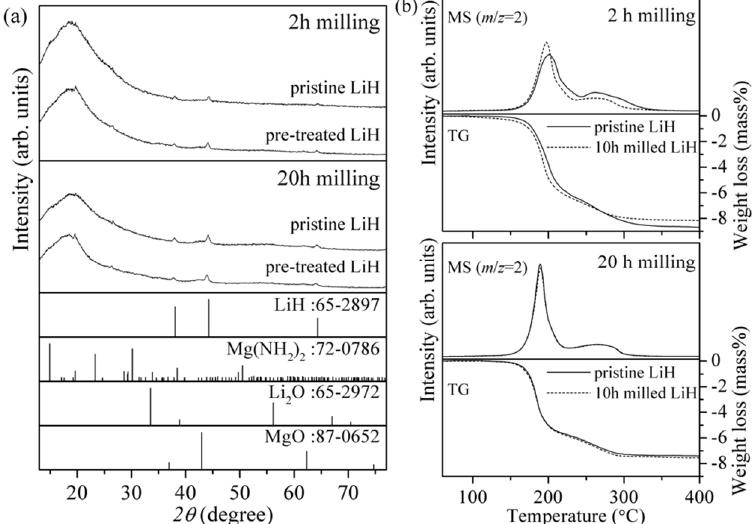
Figure 2. ( a ) XRD patterns and ( b ) TG-MS (thermogravimetry-mass spectroscopy) profiles of the 8LiH-3Mg(NH 2 ) 2 samples synthesized from the pristine or pre-treated LiH (10 h milling) by ball-milling for 2 h and 20 h. XRD patterns of LiH, Mg(NH 2 ) 2 , Li 2 O, and MgO in database are shown as